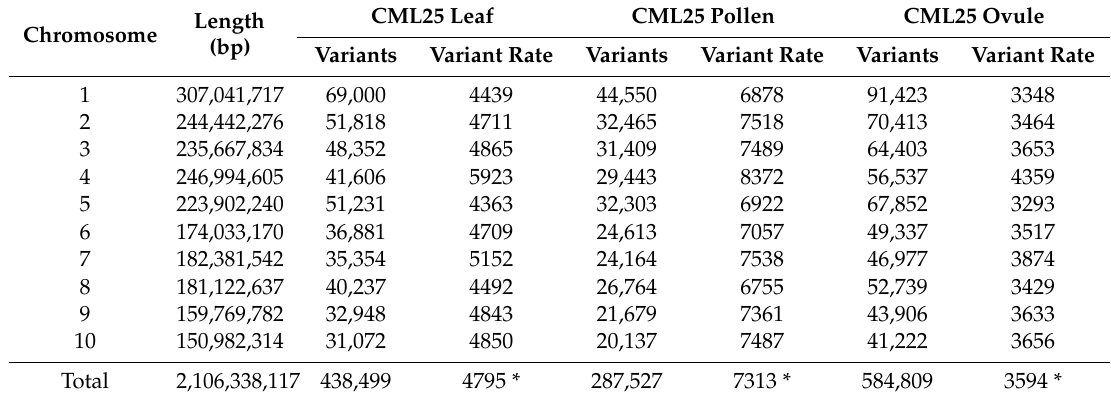
Table 3. Chromosome-wise distribution of variants in CML25.